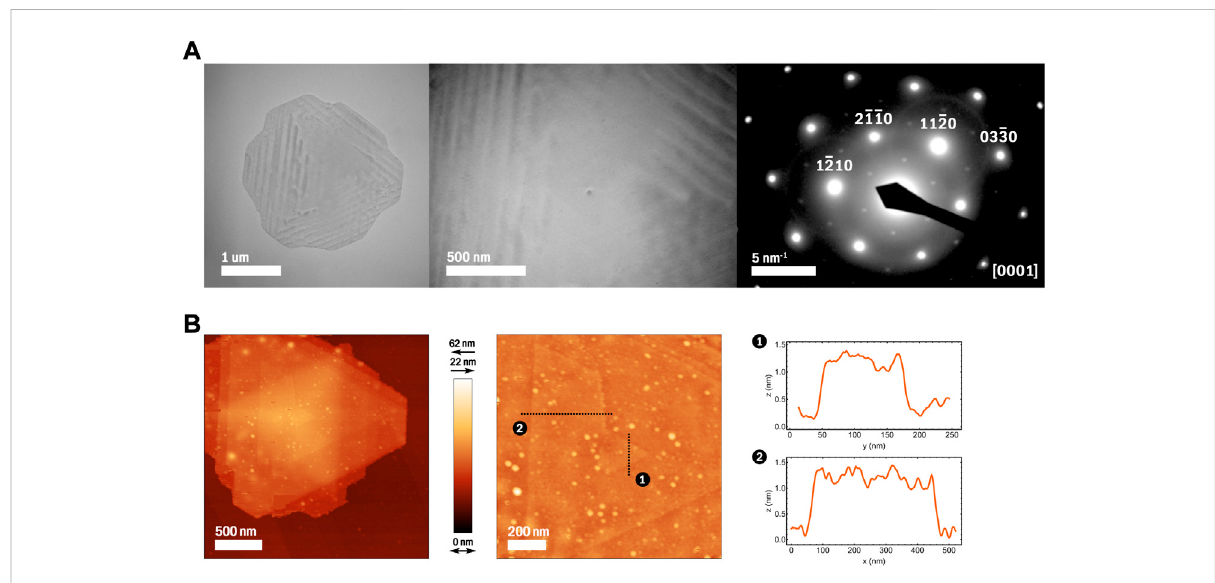
FIGURE 2 (A) TEM images and corresponding SAED pattern of an Sb 2 Te 3 spiral nanoplate with a visible core. (B) AFM images and height pro fi le plots of an